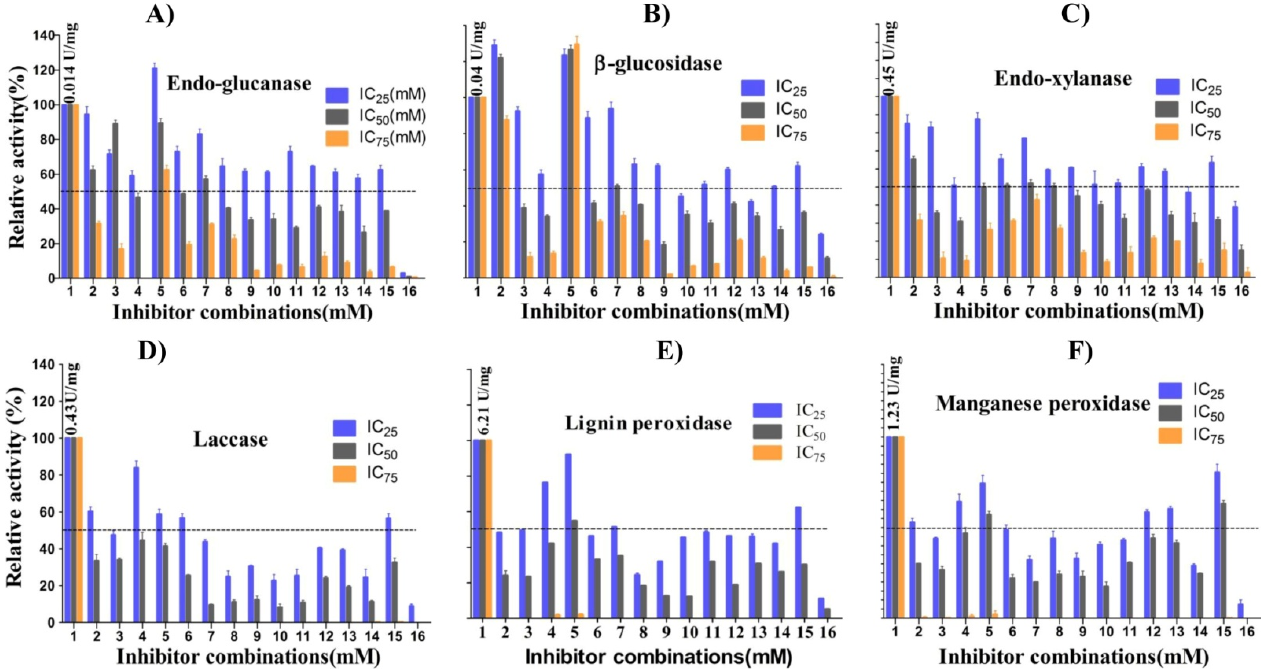
Figure 8. Effect of single and combined inhibitors on the lignocellulolytic activity of Colletotrichum sp. OH. ( A – F ) The relative activity of OH in the presence of different single and combinations of inhibitors (combinations 1–16) at their respective IC 25 , IC 50 , and IC 75 (mM) concentrations. The dotted lines show 50% inhibition of different enzymes tested in the presence of inhibitors. The values are in comparison with that of the untreated control. Specific enzyme activities as units per milligram are integrated within combination 1. Experiments were performed in triplicate, and the heights of the bars and the error bars indicate the means ± standard error mean (SEM).